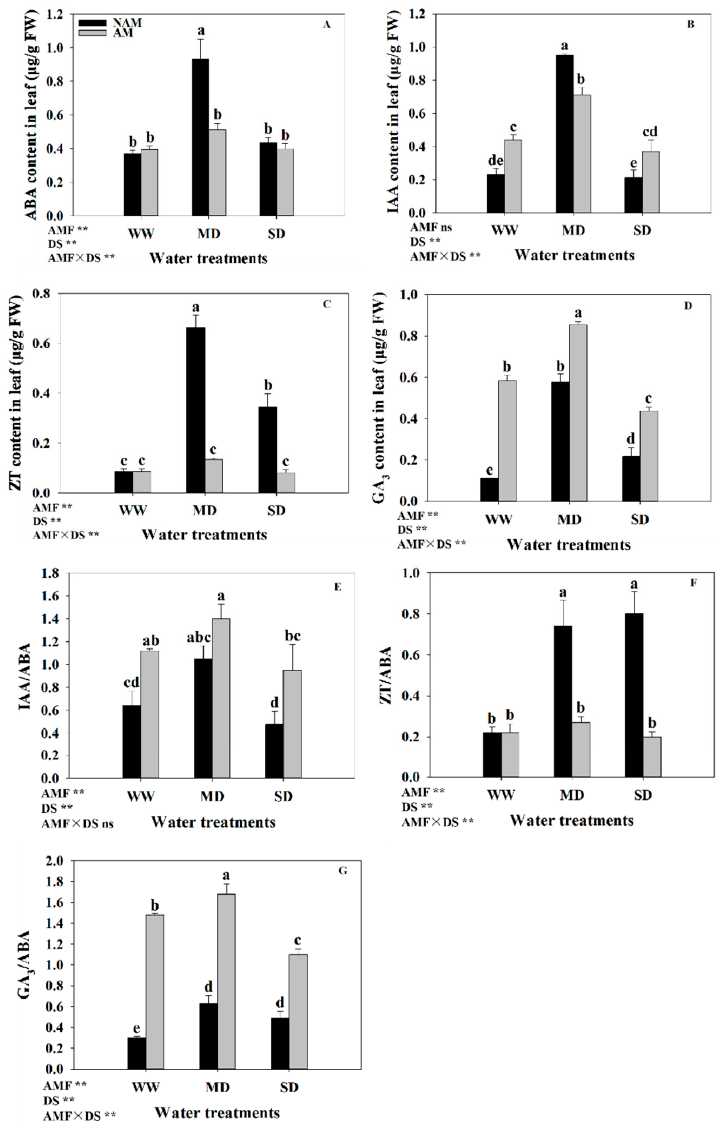
Figure 8. Effect of the arbuscular mycorrhizal fungus (AMF) Rhizophagus intraradices on the phytohormone content and ratio in Catalpa bungei seedlings under DS. ( A ), abscisic acid (ABA); ( B ), indole-3-acetic acid (IAA); ( C ), zeatin (ZT); ( D ), gibberellin (GA 3 ); ( E ), IAA/ABA; ( F ), ZT/ABA; ( G ),